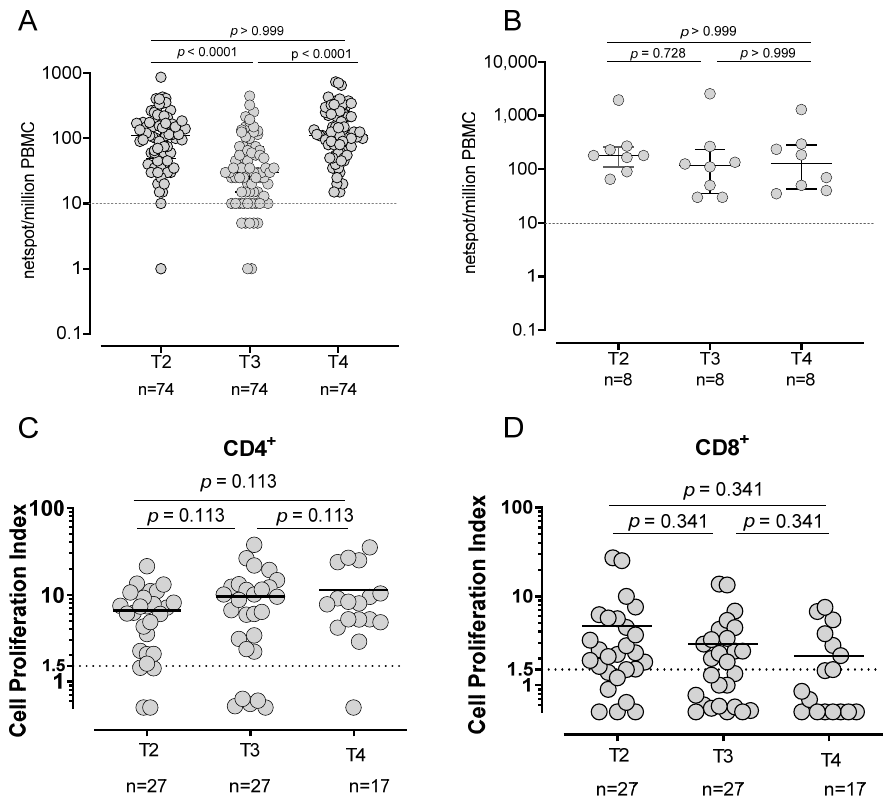
Figure 4. Spike-specific T-cell response. T-cell response in SARS-CoV-2-naïve ( A ) and -experienced ( B ) vaccinated subjects using Elispot assay. Spike-specific proliferative response in CD4+ ( C ) and CD8+ ( D ).